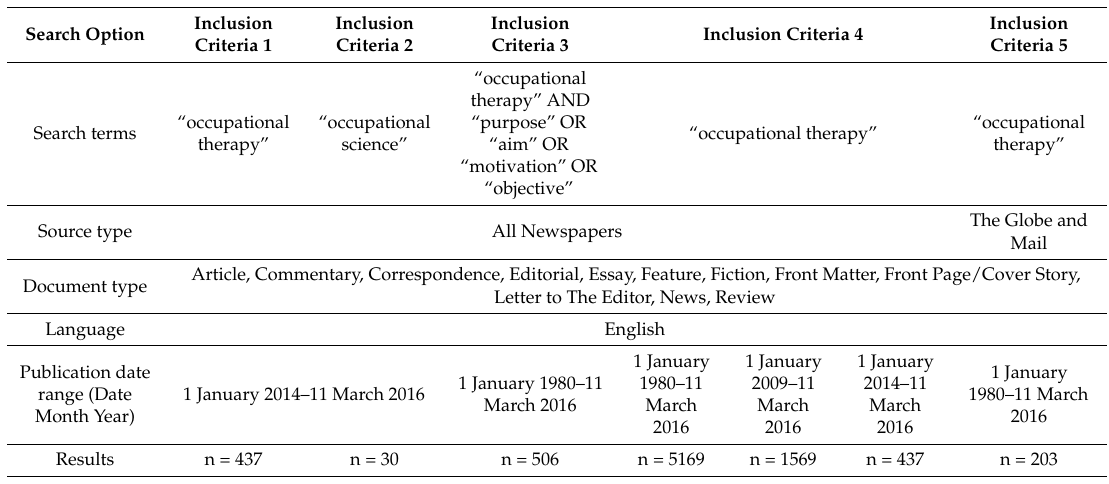
Table 1. CNC Search Strategy for identifying articles for qualitative (Inclusion Criteria 1 to 3) and quantitative data analysis (Inclusion Criteria 4 and 5).